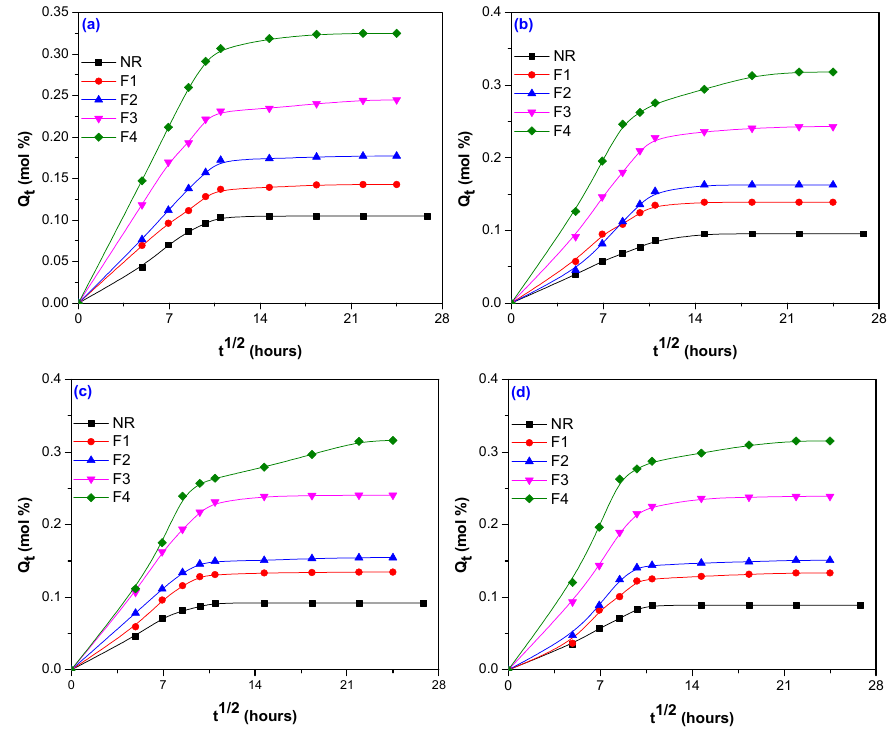
Figure 2. Q t variation versus immersion time for blends based on NR and flax, irradiated at 75 kGy ( a ); 150 kGy ( b ) ; 300 kGy ( c ) ; and 600 kGy ( d ).